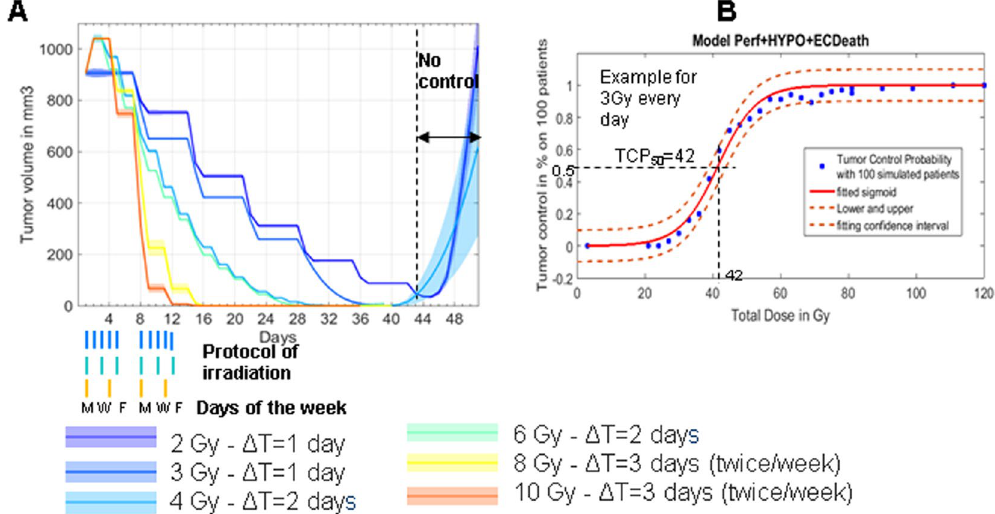
Figure 5. Determining Tumour Control Probability. ( A ) Simulated tumour volume in mm 3 for 100 “ in silico mice” as a function of day, all with a total delivered dose of 60 Gy (56 Gy for individual dose of 8 Gy, 7 irradiations). The time interval between each exposure is indicated in days as Δ T. The dose for each fraction is given in Gy. For example, 2 Gy daily for 6 weeks (purple line) does not achieve any tumour control: the majority of animals have recurring tumours at day 44. Conversely, at 3 Gy daily (blue line), 100% tumour control was obtained with a total dose of 60 Gy. ( B ) Tumour control curves for the 3 Gy daily protocol. The average % of Tumour killed for a given total dose fits a sigmoid curve. Because each fraction is 3 Gy, average points are spaced by 3 Gy interval. The fit suggests that a dose of 42 Gy would lead to 50% of mice cured from the tumour. A dose of 60 Gy (i.e. 20 fractions) would suggest 100%